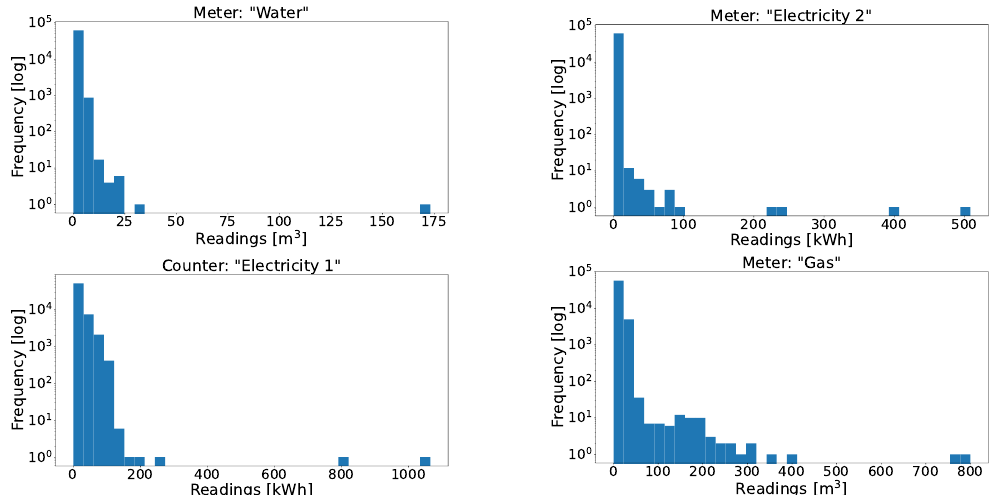
Figure 12. Histograms of the “Water”, “Electricity 1”, “Electricity 2” and “Gas” meters with the readings from January 2014 to October